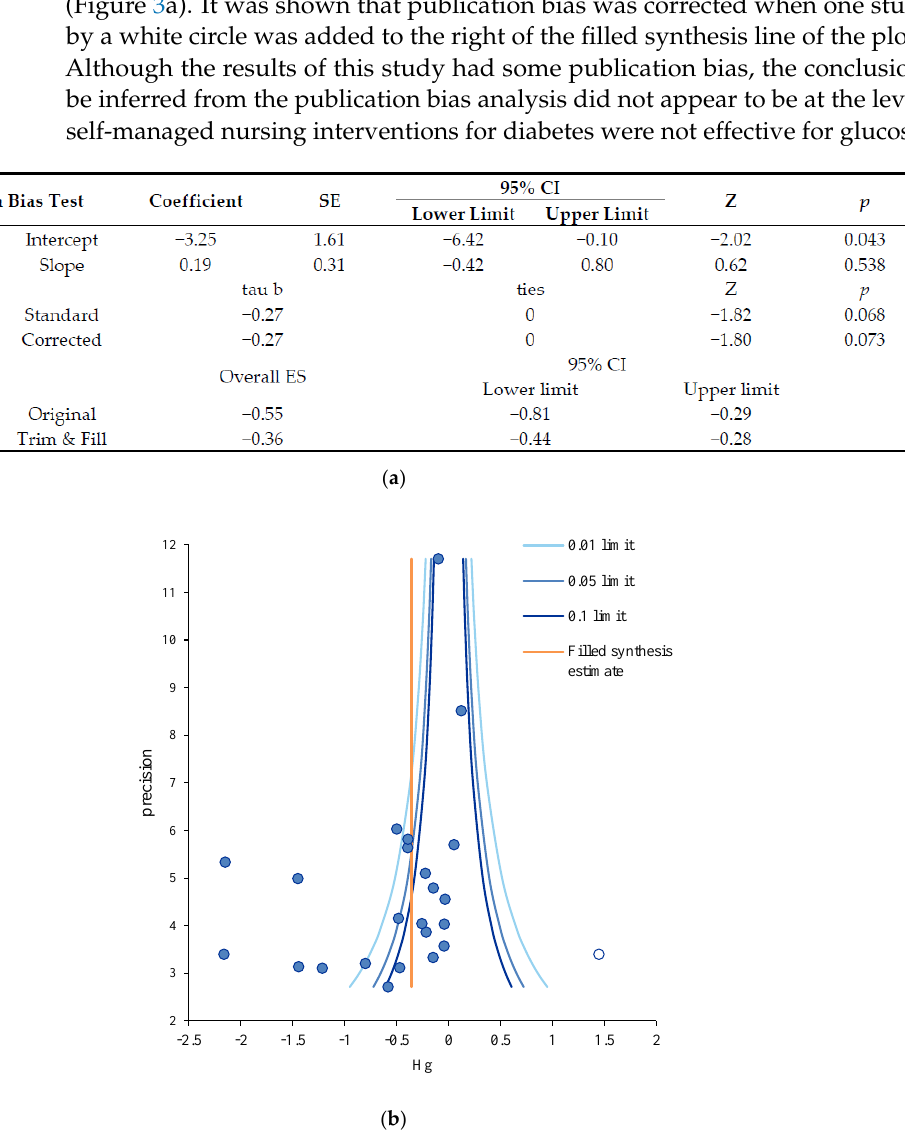
Figure 3. ( a ). Publication bias test of self-management nursing intervention on HbA1C. Notes. Egger’s regression test for zero intercept. Begg’s test for rank correlation; HbA1C: glycosylated hemoglobin, SE: standard error, CI: Confidence interval, and ES: effect size. ( b ). Trim and fill plot of self-management nursing intervention on HbA1C. Notes. Precision = 1/standard error, Hg = mean difference, 0.01 limit line = 99% confidence limit, 0.05 limit line = 95% confidence limit, and 0.1 limit line = 90% confidence